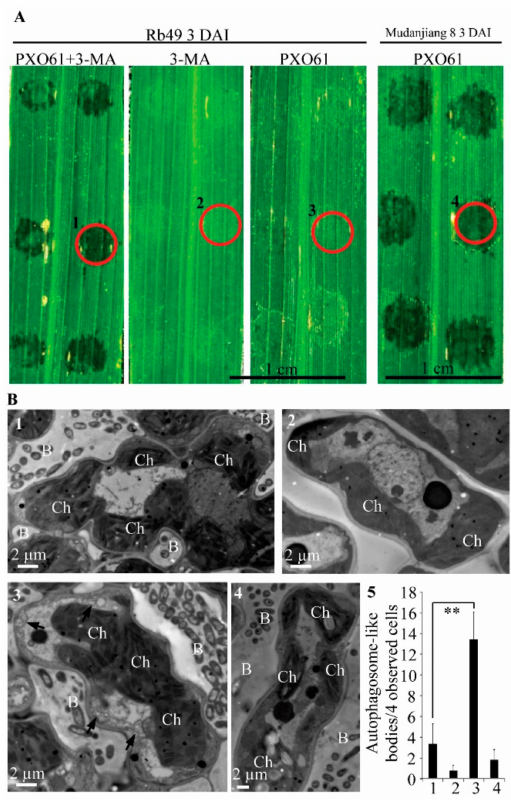
Figure 3. E ff ect of autophagy inhibitor 3-methyladenine on the water-soaked symptoms and autophagosome-like body number at inoculation sites. ( A ) The symptom of infiltration sites on Rb49, Mudanjiang 8 leaves inoculated with Xoo strain PXO61 in H 2 O solution, in 3-methyladenine (3-MA) solution, and with only 3-MA solution. The 1, 2, 3 and 4 red circles represent the observed areas corresponding to the numbers of Figure B. ( B ) Number of autophagosome-like bodies reduced by 3-MA in mesophyll cell during Xa3 / Xa26 -mediated resistance at 3 DAI. B, Xoo bacterium; Ch, Chloroplast. (1) Few autophagosome-like bodies in Rb49 leaf infiltrated with PXO61 in 3-MA solution. (2) No autophagosome-like bodies in Rb49 leaf infiltrated with only 3-MA solution. (3) Many autophagosome-like bodies (black arrow) in Rb49 leaf infiltrated with PXO61 in H 2 O solution. (4) Few autophagosome-like bodies in Mudanjiang 8 leaf infiltrated with PXO61 in H 2 O solution. (5) Number of autophagosome-like bodies per 4 observed mesophyll cells in Rb49 leaf infiltrated 1) with PXO61 in 3-MA solution, 2) with only 3-MA solution, 3) with PXO61 in H 2 O solution, and 4) in Mudanjiang 8 leaf infiltrated with PXO61 in H 2 O solution. Data represent mean (at least 3 independent leaf areas of 4 observed cells from 3 plants) + standard deviation. Double asterisks (**) indicate a significant di ff erence ( p < 0.01) between 1) Rb49 infiltrated with PXO61 in H 2 O solution and 3) Rb49 infiltrated with PXO61 in 3-MA